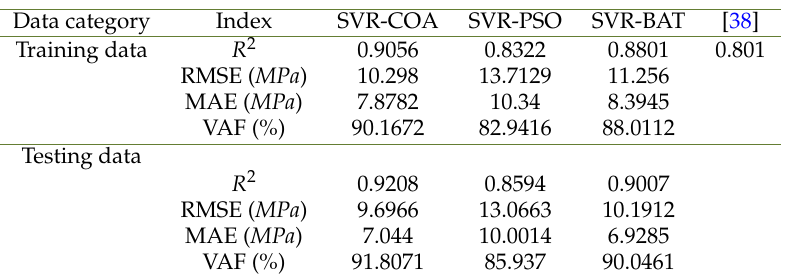
Table 4. The values of performance evaluation criteria.